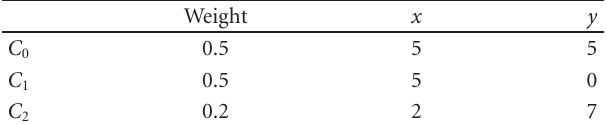
Table 4: An example of the signature C .